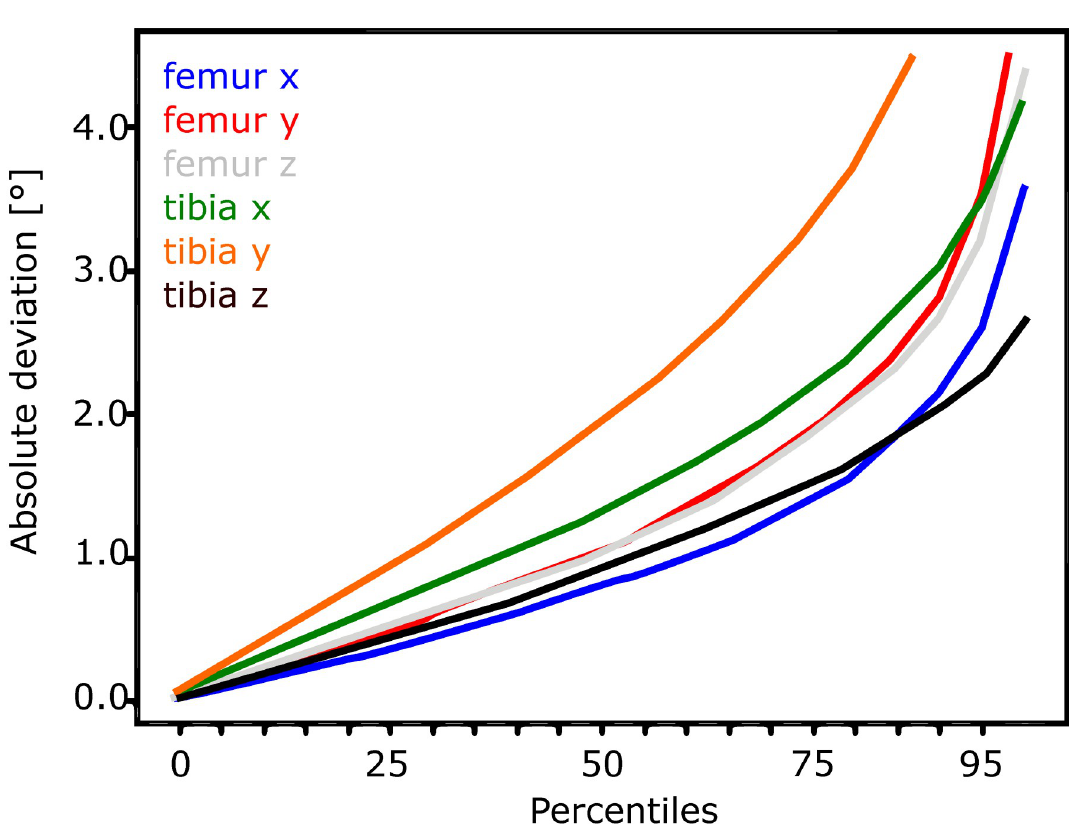
Fig 5. Rotation (right) performance for the individualised 2-iteration DAMN on the